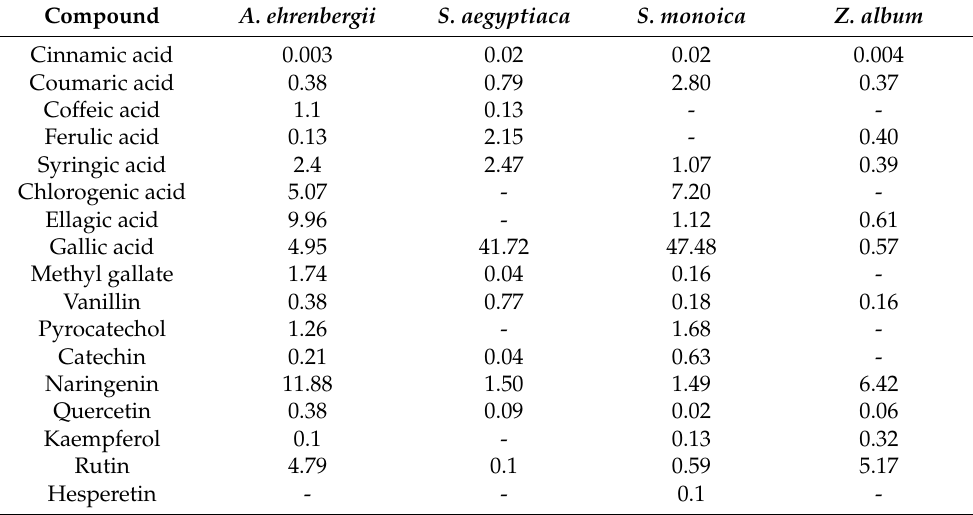
Table 2. Phenolic contents of the investigated Red Sea halophytes (mg/g; n = 2).